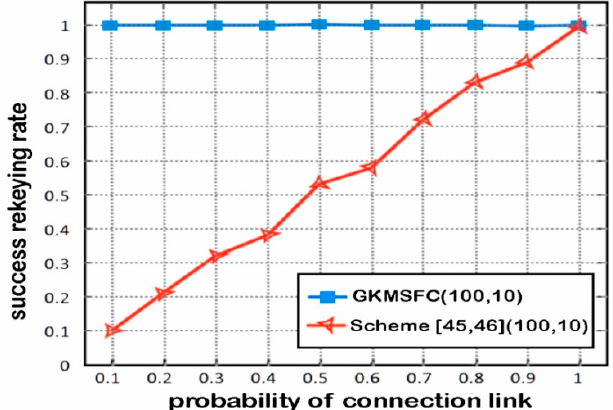
Figure 4. Rekeying success rate under different connectivity probability.